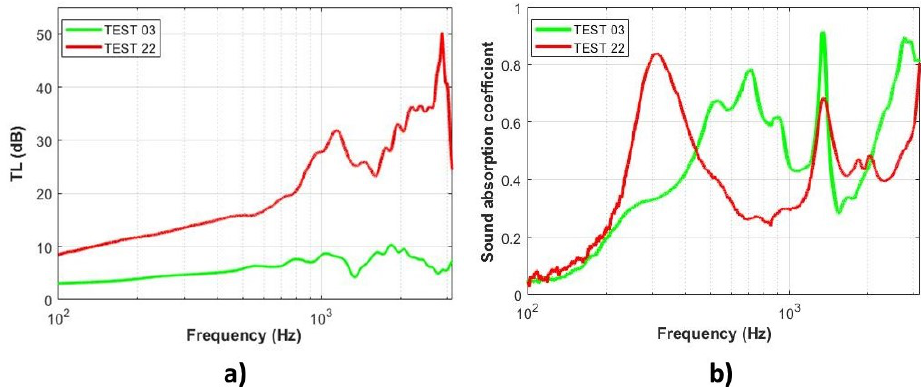
Figure 9. Transmission loss ( a ) and absorption coefficient ( b ) of samples made of at least on egg-box and polyester.